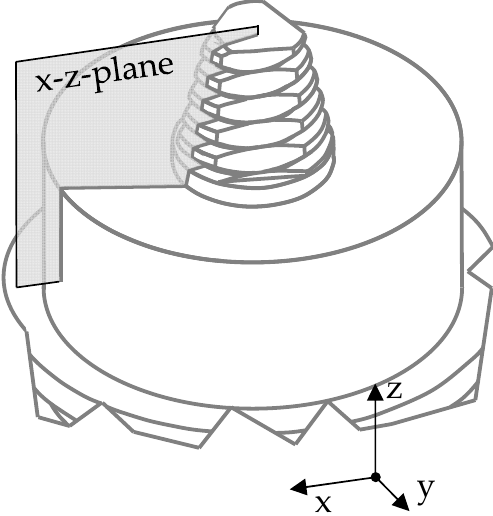
Figure 3. Measuring plane on the friction stir welding (FSW) tool.